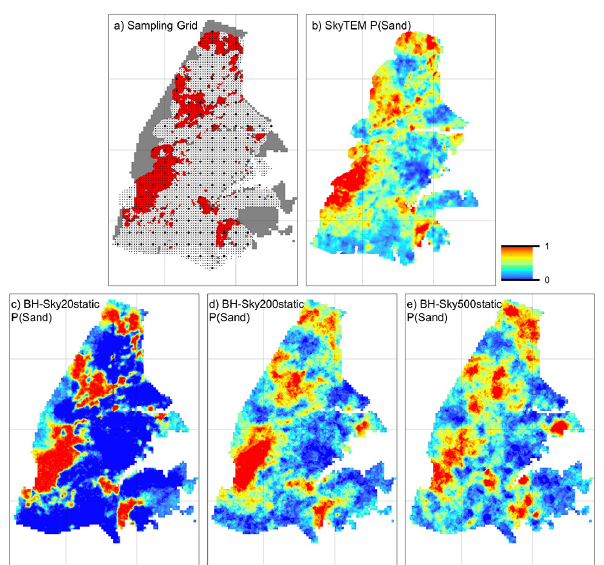
Figure 8. (a) : 100m (small dots) and 500m (big dots) sampling grids for thinning out the conditioning data set. (b–e) : probability of sand at an elevation of 49m for SkyTEM data set (b) , and for static 20, 200 and 500m conditioning (c–e) . Red colors represent high sand probability and blue colors low sand probability (based on 25 realizations).